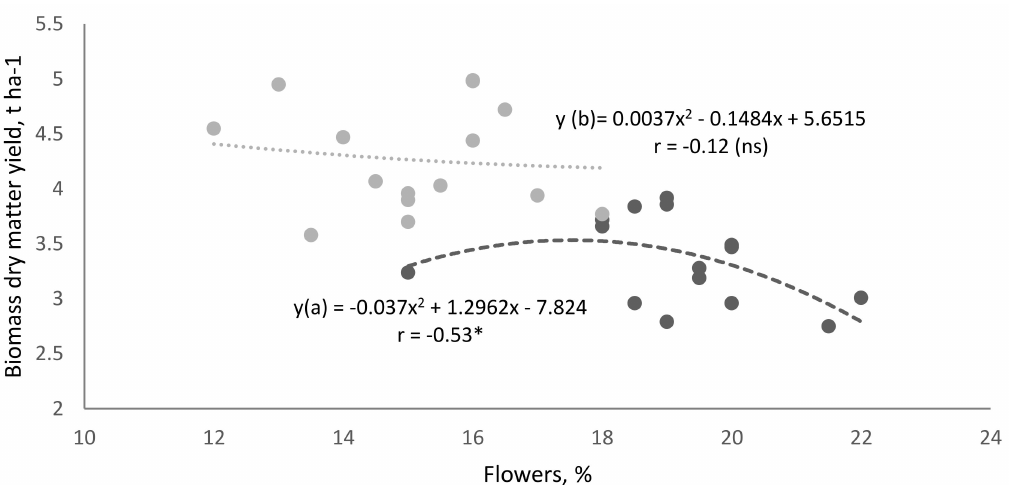
Figure 3. Correlation between morphostructural elements of buckwheat plants and biomass dry matter yield: a—organic farming system, b—conventional farming system (*—Significant values with p < 0.05; **—Significant values with p < 0.01; ns—not significant).